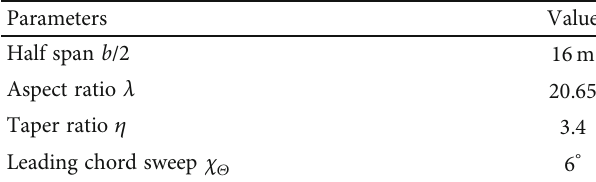
Figure 5: Comparison of calculated results and experimental results. Table 1: Geometrical parameters and airfoil